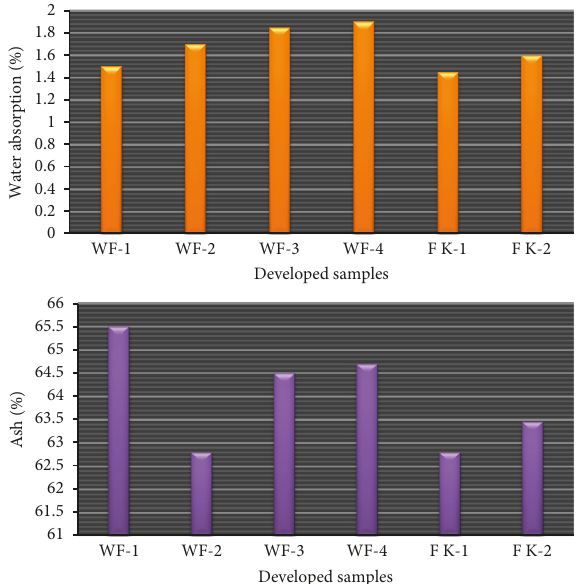
Figure 5: Water absorption and ash percentage of newly developed composites.